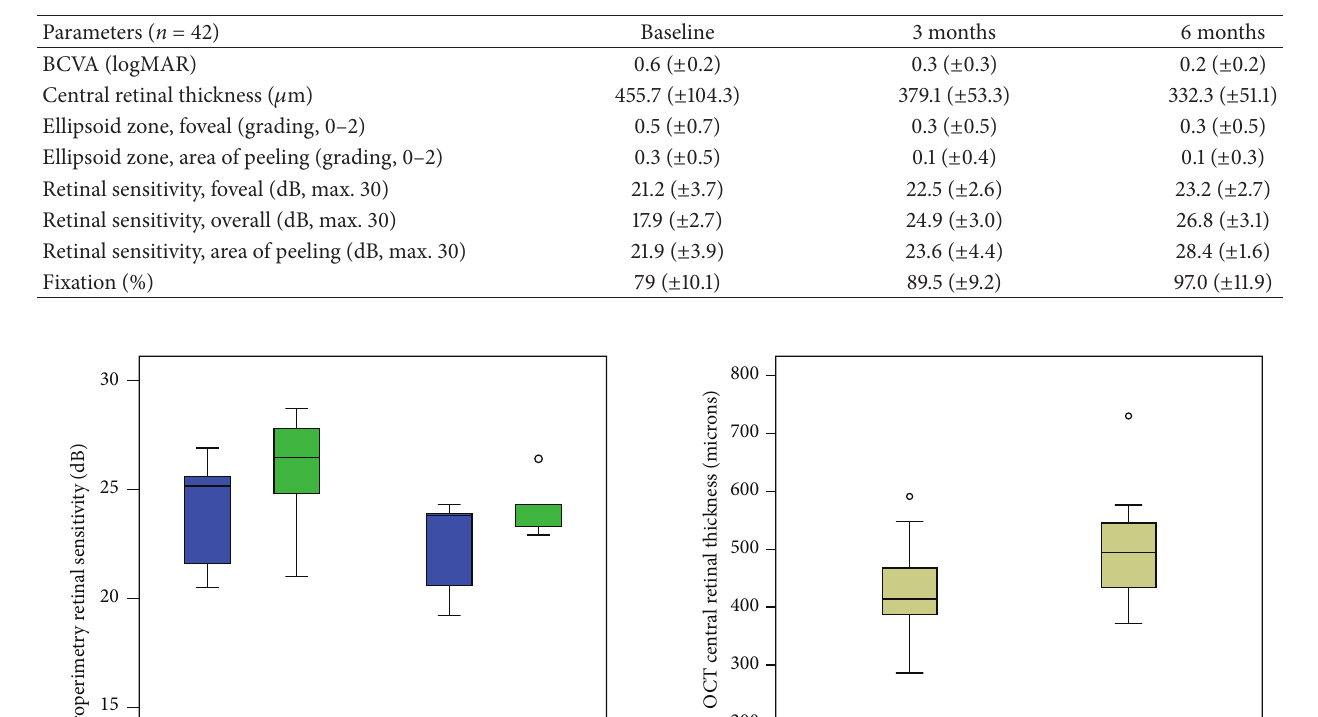
Table 1: Overall data assessment during 6-month follow-up.